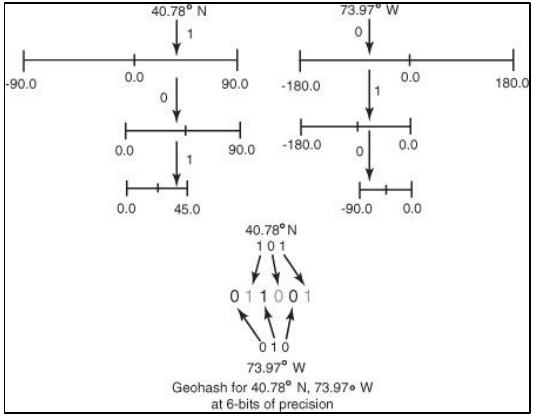
Figure 2. Niemeyer's Binary Interleaving for Geohash